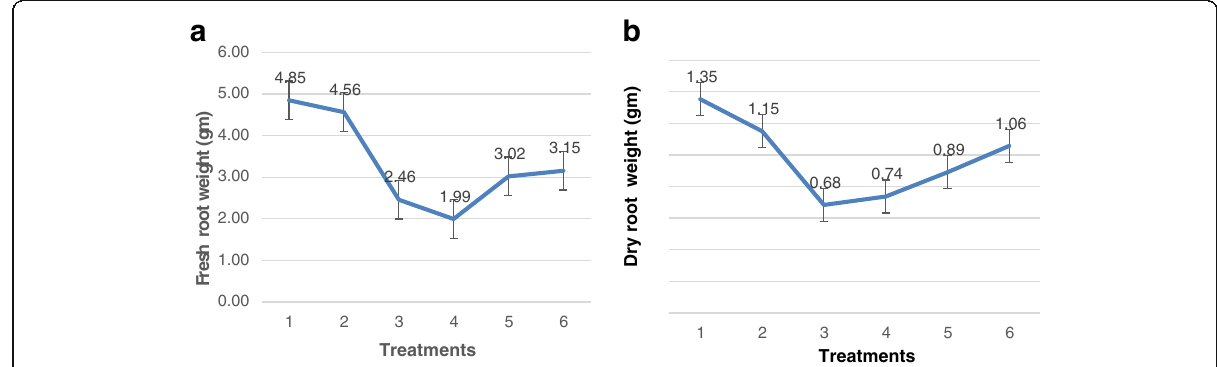
Fig. 2 Effect of soil infection with Trichoderma harzianum , Phythium ultimum , and Phytopthora capsici on tomato fresh weight (g) in a pot experiment ( a ). Effect of soil infestation with T. harzianum on P. ultimum and P. capsici on tomato dry root (g) in a pot experiment ( b ). 1, uninoculated control (healthy); 2, T. harzianum (alone); 3, inoculated with P. capsici (alone); 4, inoculated with P. ultimum (alone); 5, inoculated of P. capsici with T. harzianum ; 6, P. ultimum with T.